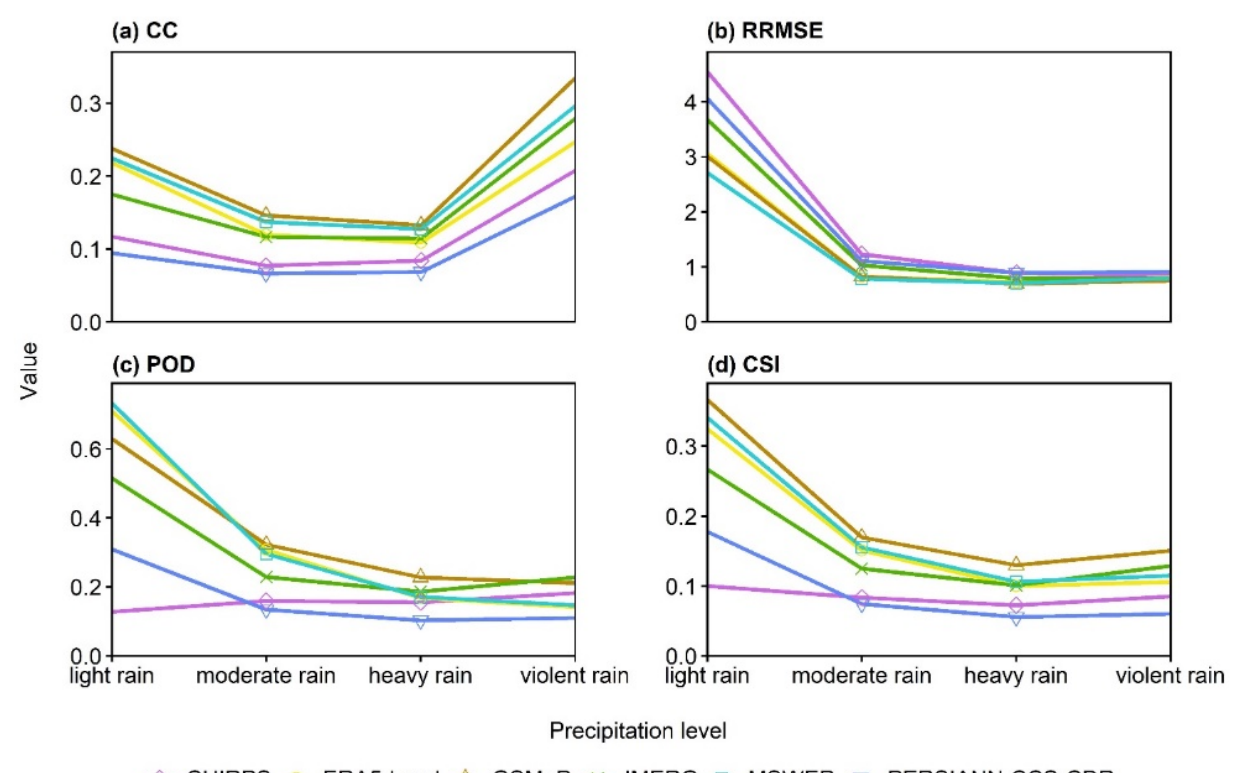
Figure 3. Mean values of four statistical metrics of precipitation products at four precipitation levels between 2015 and 2019. From left to right and top to bottom: (a) CC, (b) RRMSE, (c) POD and (d) CSI.